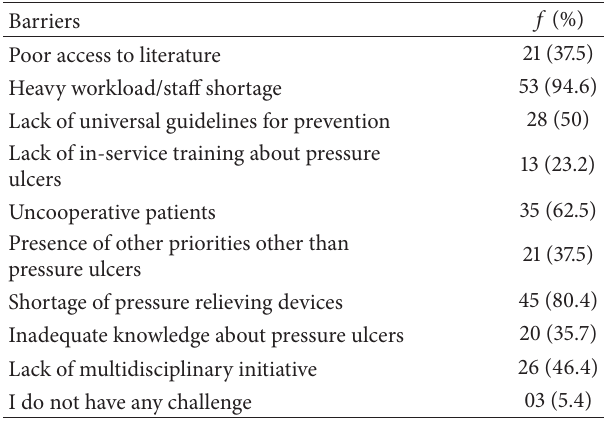
Table 5: Barriers to carrying out pressure ulcer management and prevention (multiple